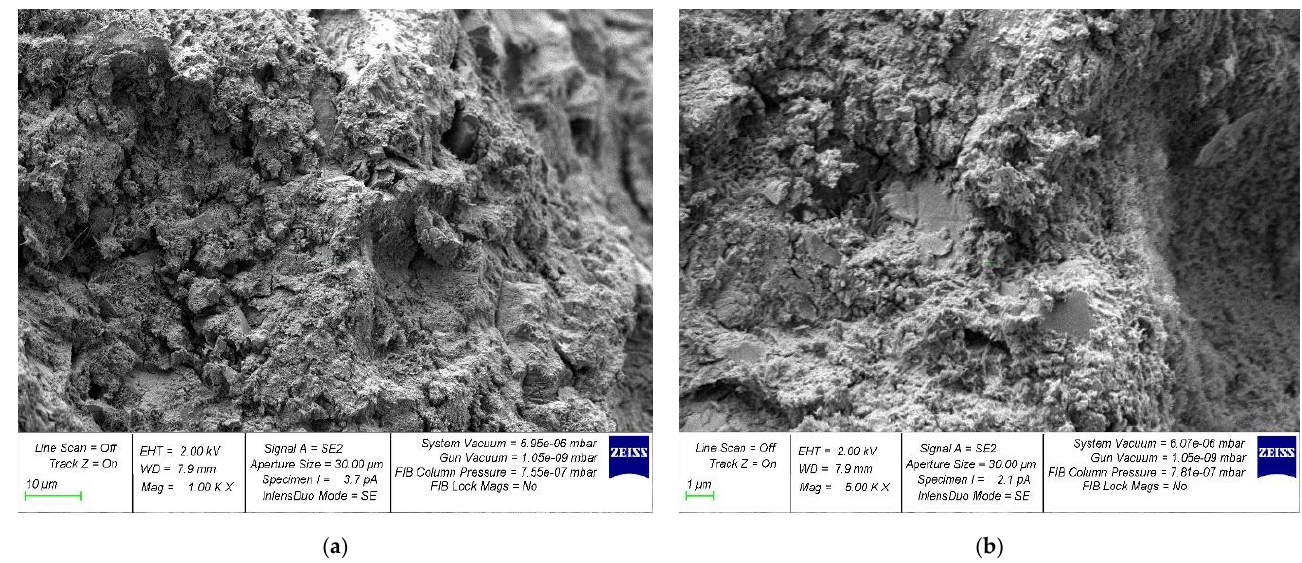
Figure 14. Samples of the control composition: ( a ) 1000×; ( b ) 5000×.